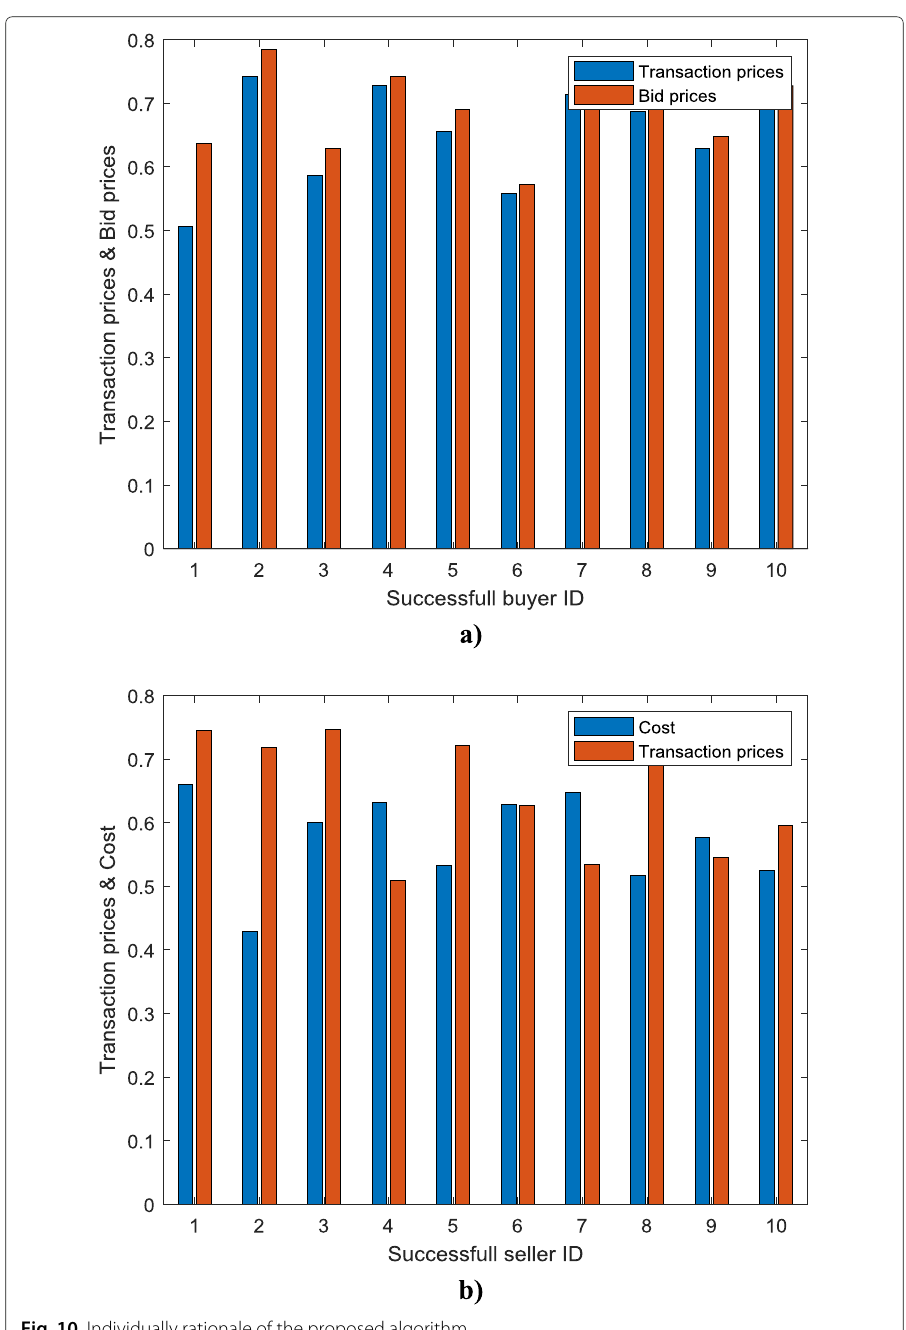
Fig. 10 Individually rationale of the proposed